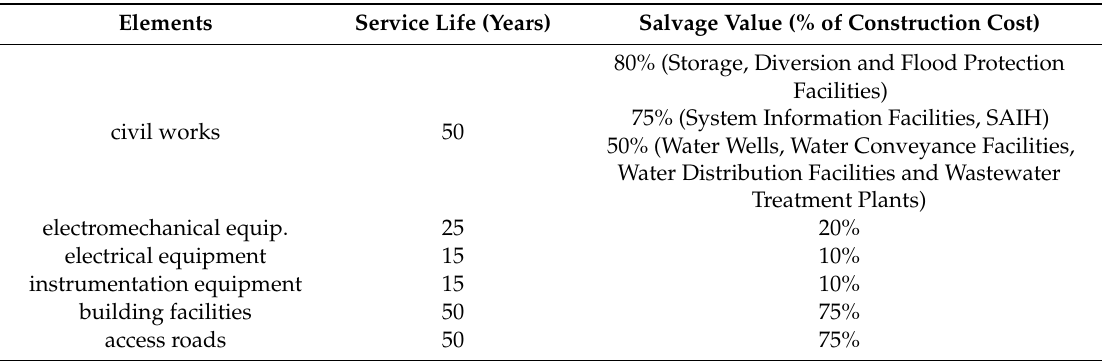
Table 5. Asset Service Life and Salvage Value [49].